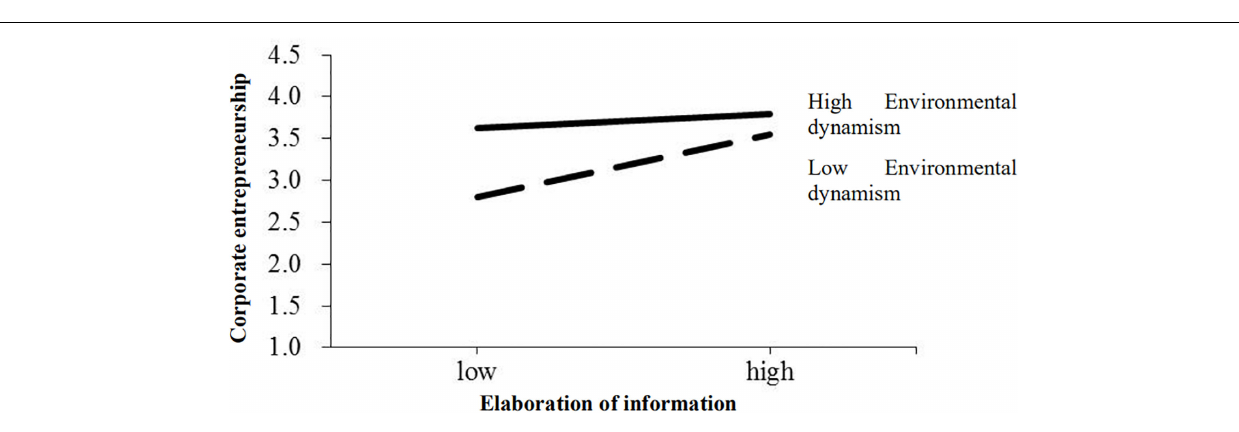
FIGURE 3 | Interaction between elaboration of information and environmental